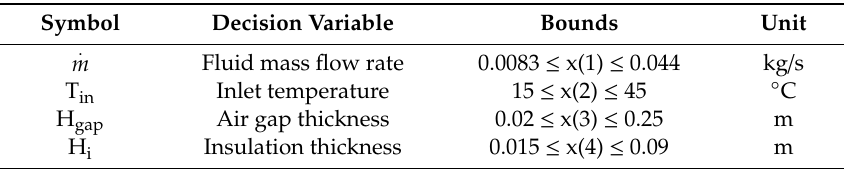
Table 3. Decision variables for multi-objective optimization